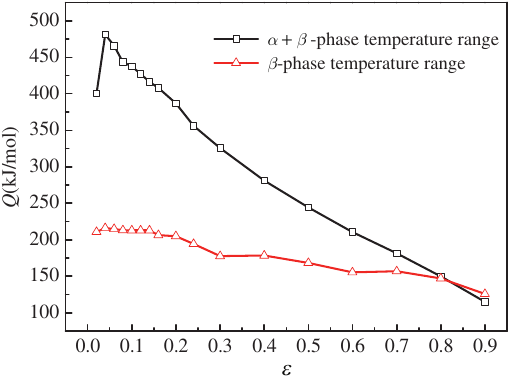
Figure 5 The relationship between Q and Figure 2, as the variation of flow stress with strain in